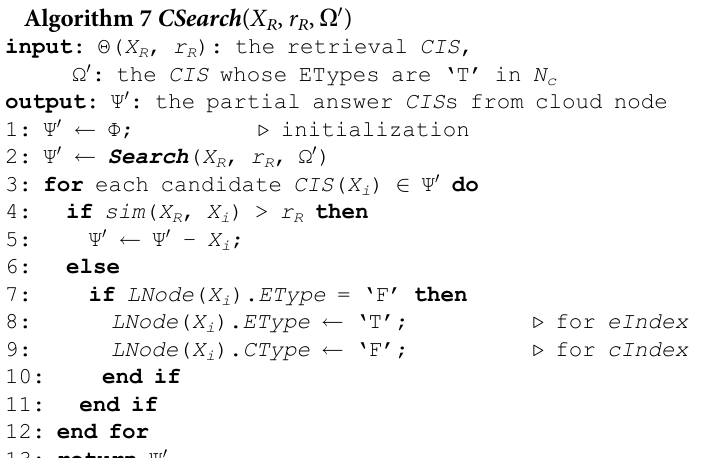
Algorithm 7 CSearch ( X